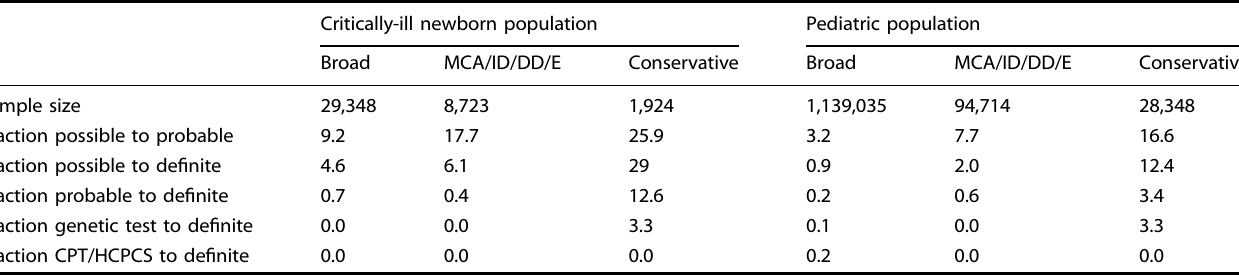
Table 3. Diagnostic